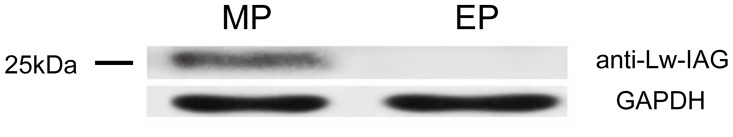
Western Blot analysis of the Lw-IAG protein in Lysmata wurdemanni.MP: male phase, EP: euhermaphrodite phase. A 25 kDa band only existed in the male-phase shrimp.